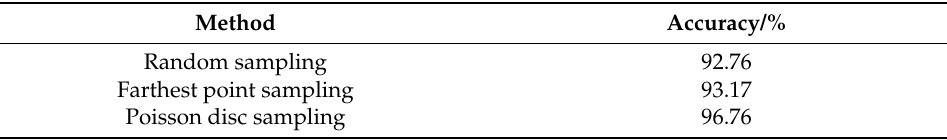
Table 4. Classification accuracy of different sampling